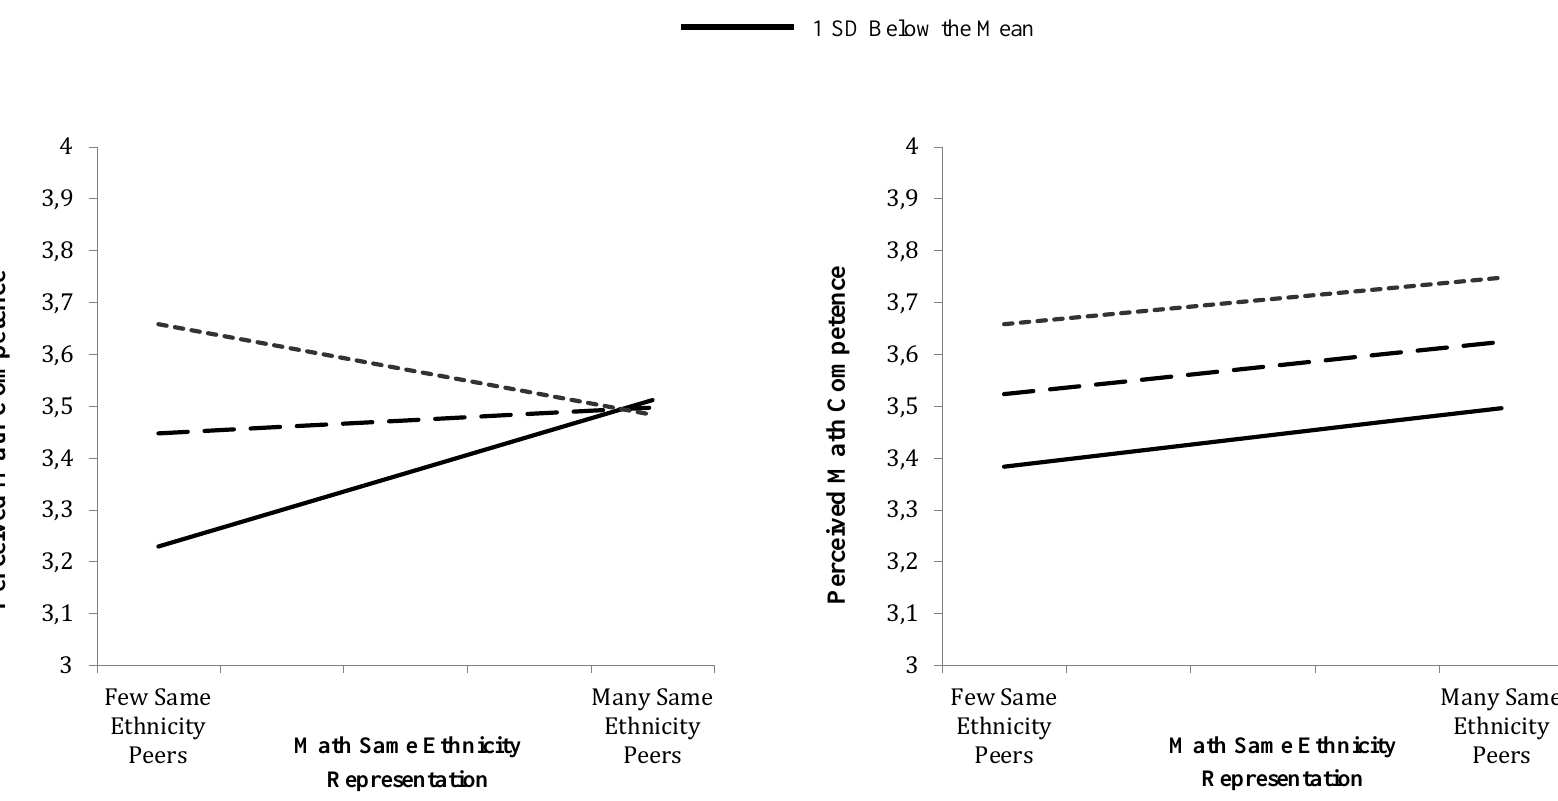
Figure 1 . The three way interaction between ethnic climate, math level, and math same-ethnic representation on perceived math competence (left panel = Algebra I, right panel = advanced